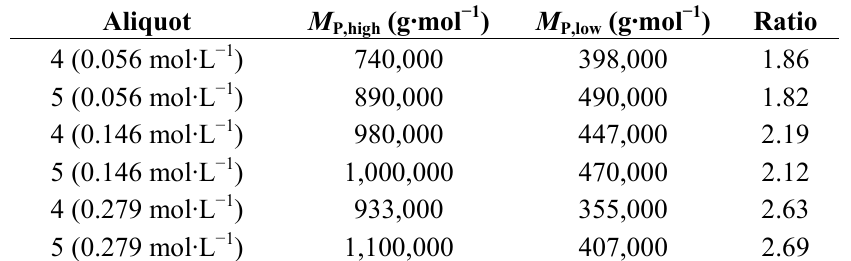
Table 1. Comparison of the molecular weights of the two maxima of the MWDs of selected aliquots resulting from the copolymerization of BA and different amounts of